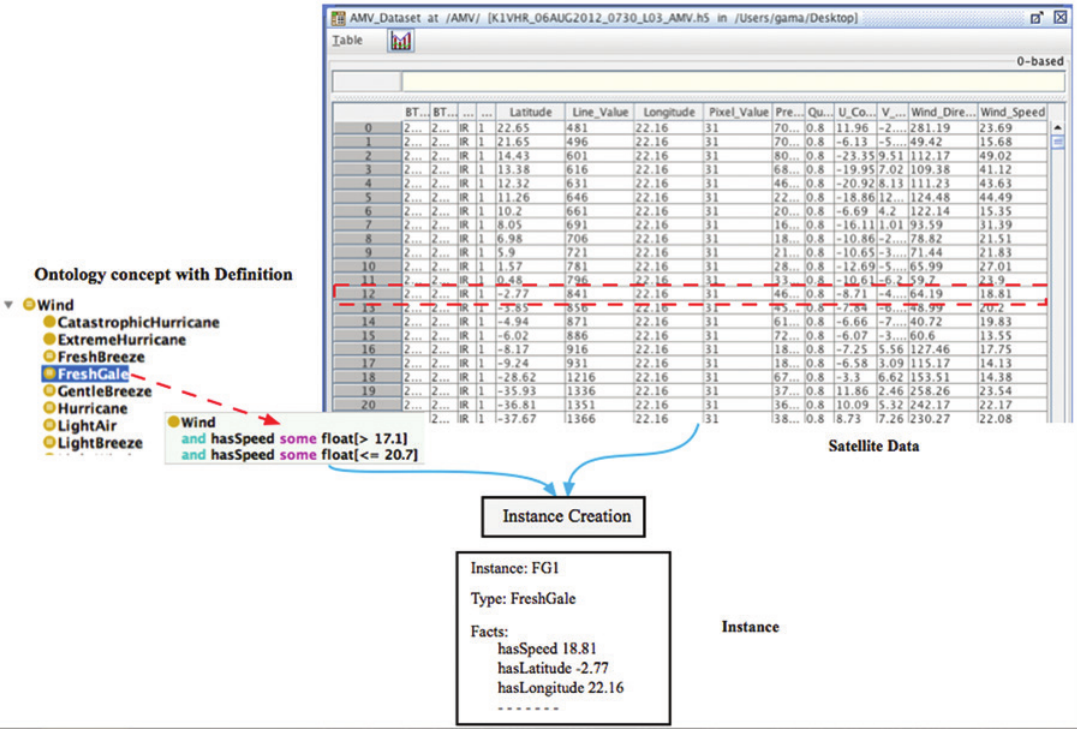
Figure 2: Instance Creation from Satellite Data Using Ontology Concept